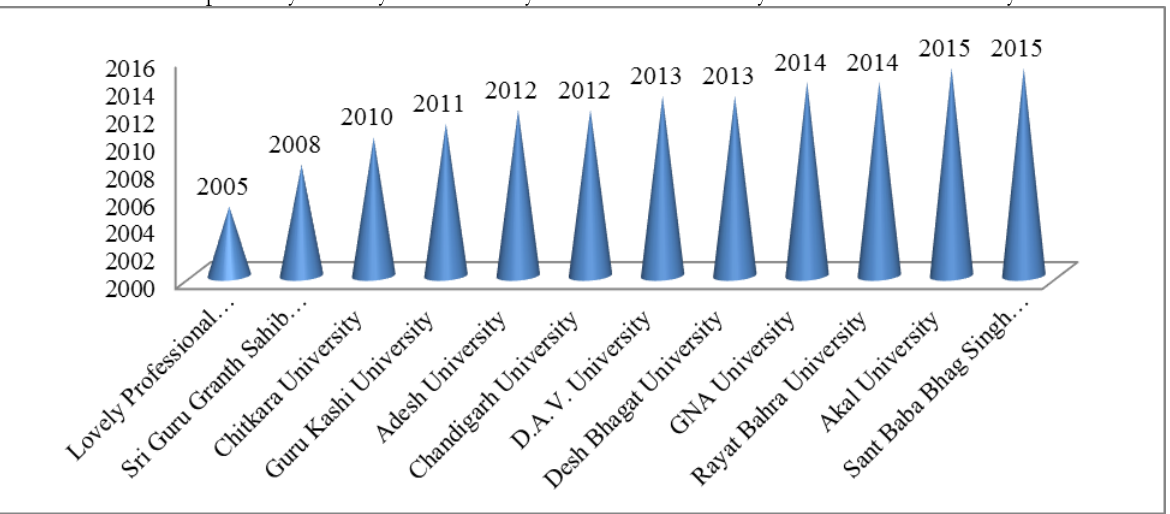
Figure 5. Private Universities in